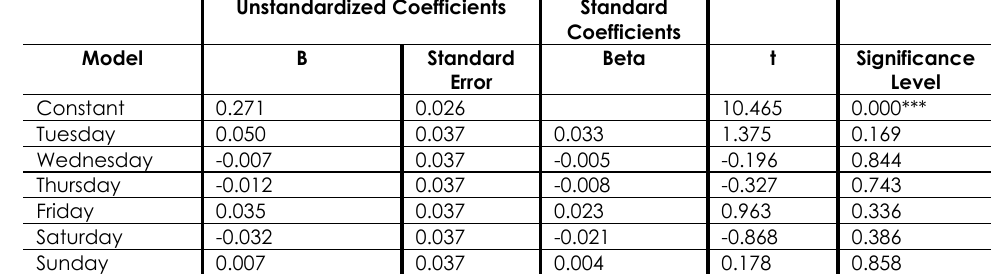
Table 14. Table of coefficients in the model established to determine whether there is a day effect on accidents.